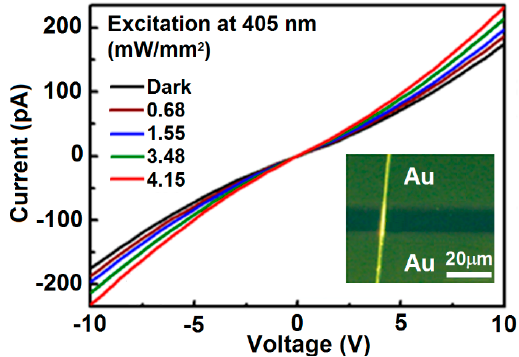
Figure 6. I–V curves measured on the photoconductive device based on a single F8BT fiber under different excitation power density. Inset: optical microscopic image of the device.